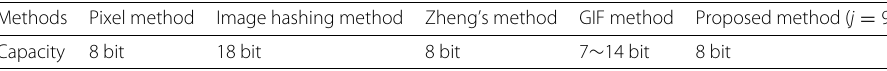
Table 2 Hidden bit number comparison in one